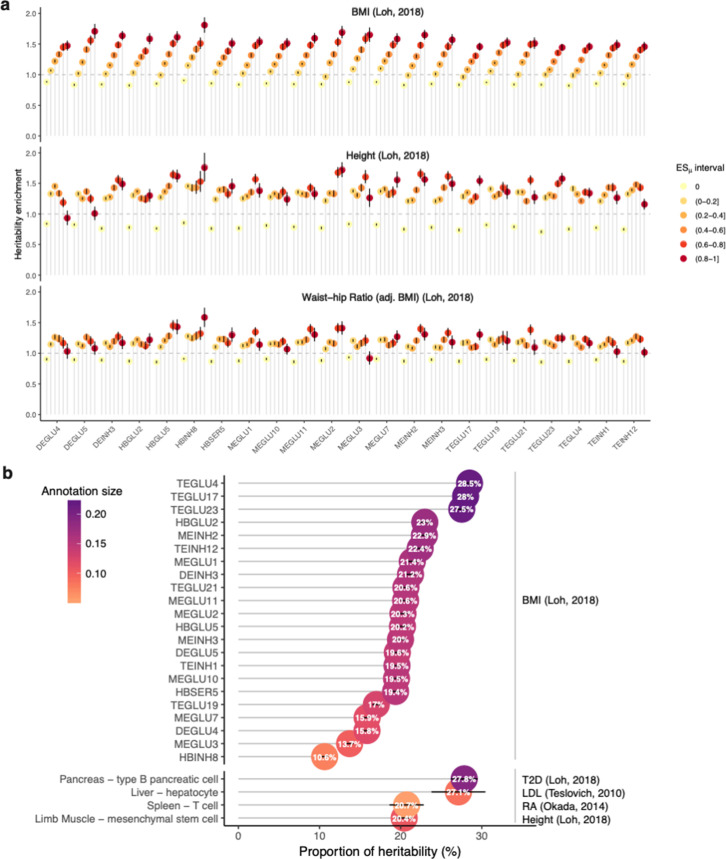
Heritability of BMI prioritized cell types.(a) Heritability enrichment of cell type ESμ intervals. Heritability enrichment was estimated using S-LDSC on cell type ESμ annotations partitioned into five equally spaced intervals and an interval including ESμ=0. The intervals 0 and (0.8–1) represent the heritability enrichment of by the variants with the lowest and highest ESμ values, respectively. Error bars represent 95% confidence intervals. The top, middle and bottom panel show results for BMI, height and waist-hip ratio, respectively. BMI heritability enrichment increases with increasing ESμ value for prioritized cell types. (b) Proportion of BMI heritability explained by prioritized cell types. We used S-LDSC to estimate the proportion of trait SNP heritability explained by each cell type annotation. For comparison we report the proportion of heritability explained by cell types with known etiology for selected traits: type 2 diabetes (T2D), low-density lipoprotein (LDL), rheumatoid arthritis (RA) and human height. Circles are colored by annotation size reflecting the proportion of variants covered by the cell type annotation (a value of one means that all variants were covered). Error bars represent 95% confidence intervals.